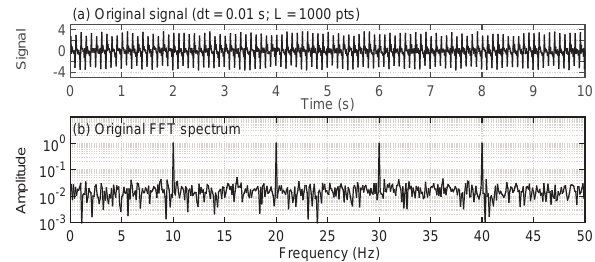
Figure 1. (a) Synthetic signal and (b) its associated FFT amplitude spectrum. The signal consists of four sinusoidal modes, with ampli- tude 1 and frequencies f 1 = 10Hz, f 2 = 20Hz, f 3 = 30Hz and f 4 = 40Hz, plus